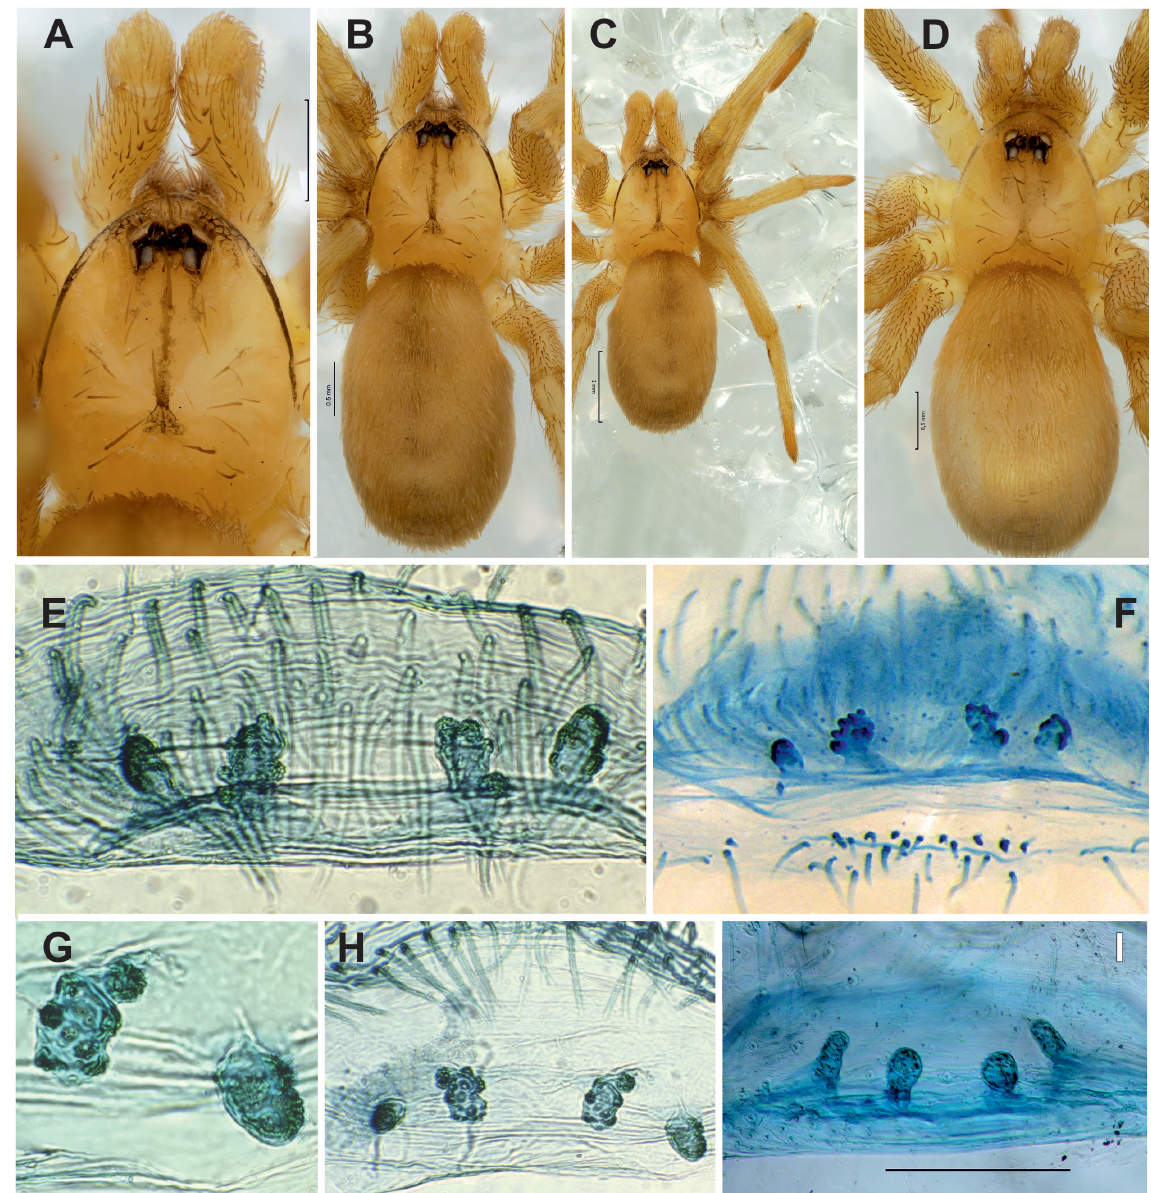
Fig. 38. Somatic characters and endogyne of Zaitunia maracandica (Charitonov, 1946), ♀♀ from Bukhara ( A – D ), Kitab ( E – H ) and Ulus ( I ). A . Prosoma, dorsal. B , D . Body, dorsal. C . Habitus, dorsal. E – F , I . endogyne, dorsal. G . right pair of receptacles, anterior. H . endogyne, anterior. Scale bars: B, D = 0.5 mm; C = 1.0 mm; i = 0.2